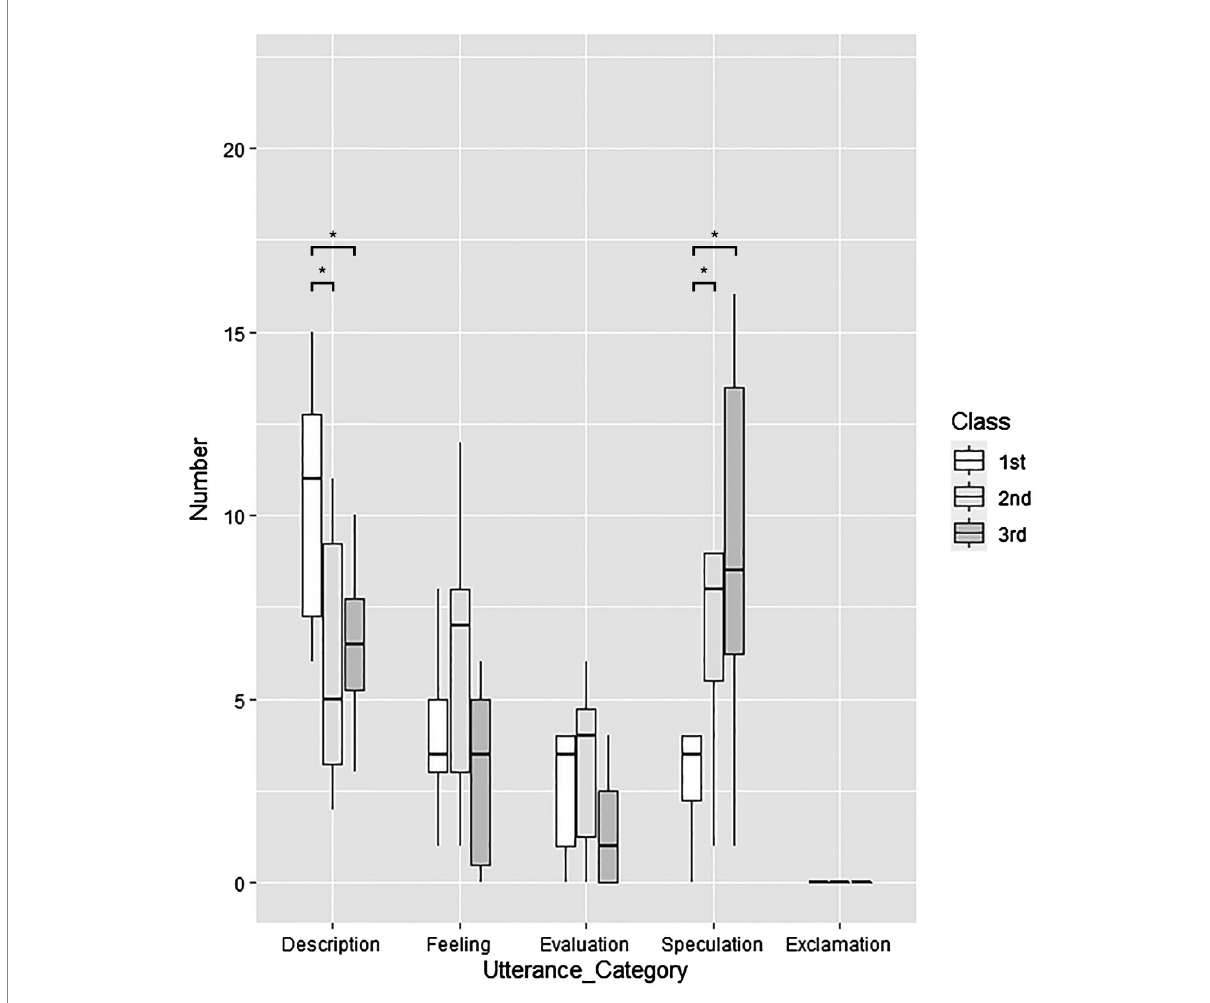
FIGURE 1 Novice actors’ changes with the progression of Repetition training in the number of each kind of utterance per session (* p <